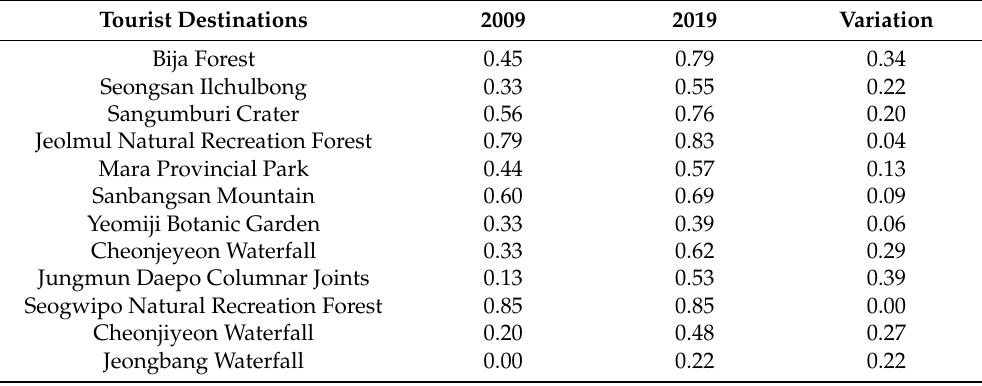
Table 5. Habitat quality change estimated by InVEST Habitat Quality model in 12 tourist destinations on Jeju (2009–2019).